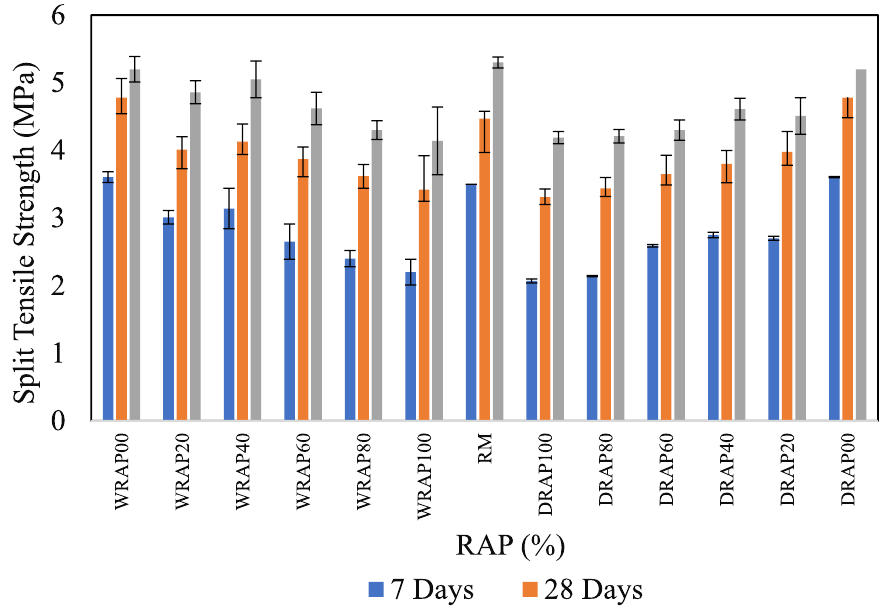
Figure 7. Influence of Split tensile strength in RAP-based concrete.